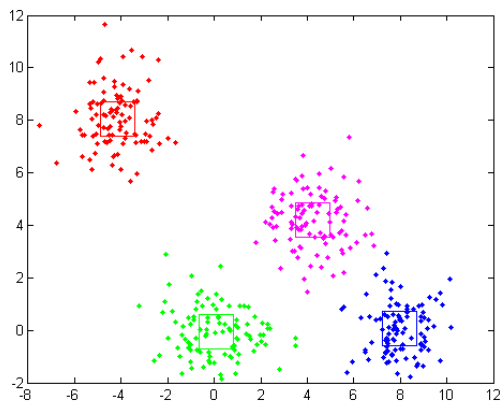
Figure 19. Graphic representation of some clusters and highlighting of centroid.